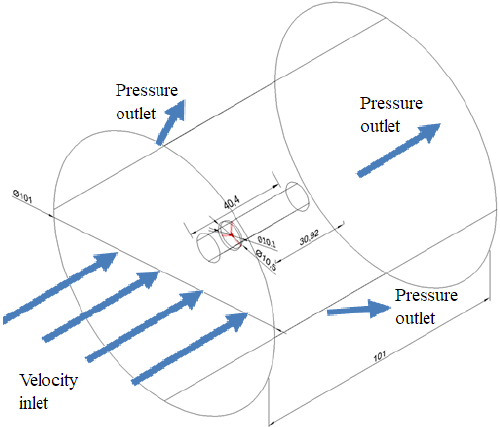
Figure 2. The schematic diagram of the spatial computational domain.